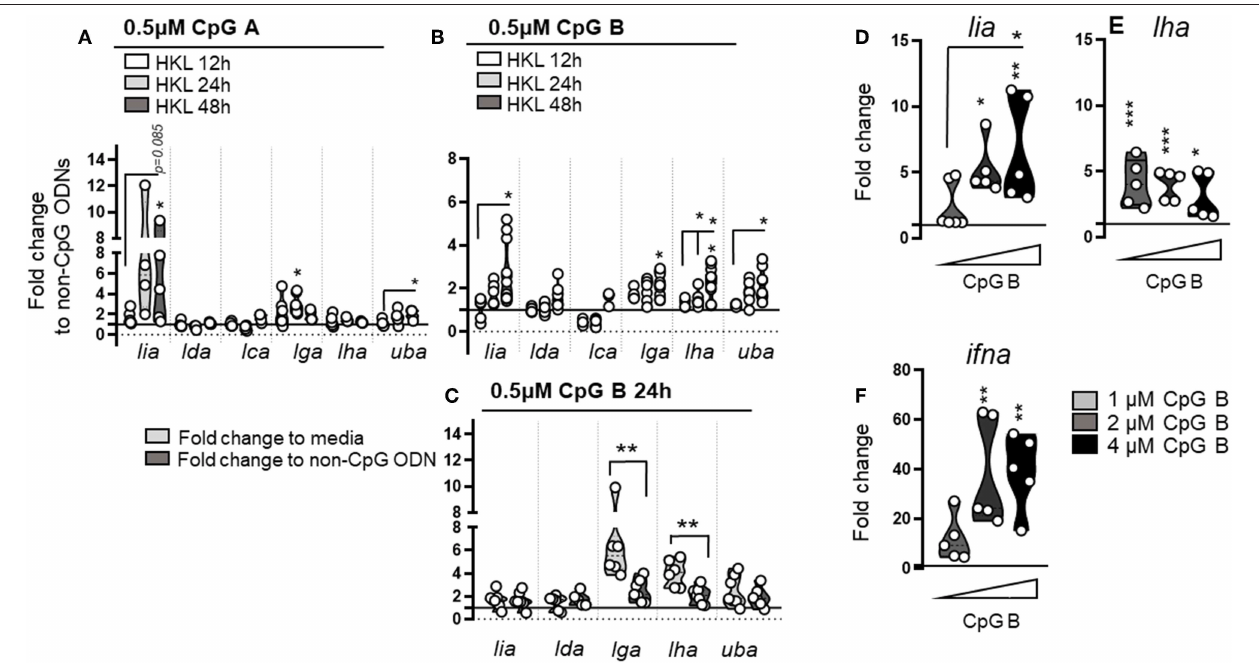
FIGURE 8 | Stimulation with different classes of ODNs containing unmethylated CpG motifs induces lineage specific MHC class I L lineage expression. Expression of MHC class I L lineage ( lia, lda, lca, lga, lha, and lfa ) in HKL stimulated with 0.5 µ M CpG A (A) or CpG B (B) ODNs for 12h (white), 24h (light gray), and 48h (dark gray). Gene expression data at each time point were normalized against the reference gene EF1 α B and fold changes were calculated using cells stimulated with non CpG containing ODN controls at the same time point. The data represents least five individuals [n ǫ (5;8)] with each dot representing cells isolated from an individual fish. (C) Fold change in gene expression calculated using cells stimulated with either media alone (light gray) or non-CpG containing ODNs (dark gray) at 24 hps. (D–F) Expression of lia , lha , and type I ifna in HKL stimulated with increasing concentrations of CpG B for 48h. The line intersecting the y-axis at 1 represents the control that the fold change of the treatments is in relation to. Asterisks indicates the strength of significance between the indicated time points and asterisks above each violin indicate significant upregulation compared to control stimulated cells: * p < 0.05, ** p < 0.001, *** p <